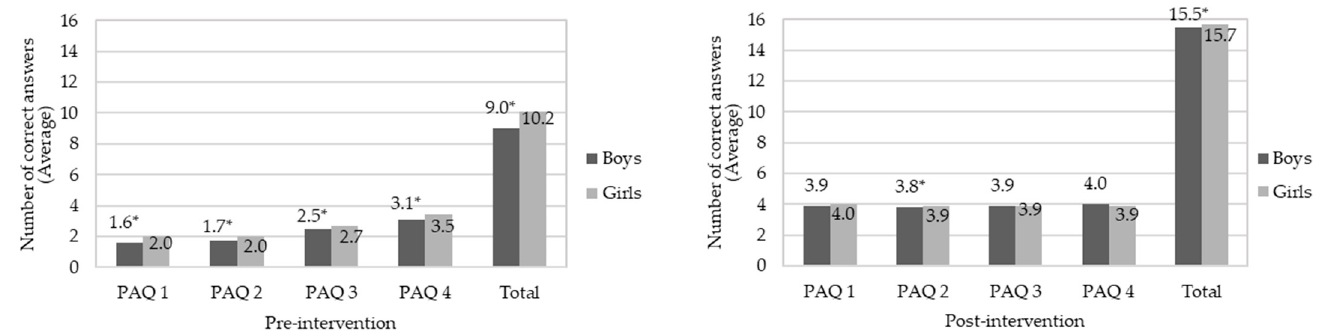
Figure 7. Average of correct answers to questions about knowledge about physical activity in pre- and post-intervention stages, compared between genders. * Means indicate significant difference by Student’s t test ( p -value < 0.05) in the same question. Physical Activity Questions (PAQ): PAQ 1—“Physical activity performed daily prevents which these diseases?”; PAQ 2—“Can exercise lack leads a person to have?”; PAQ 3—“What the practice physical activity improves on a daily basis?”; PAQ 4—“What activities can help you to have good health?”; Each question contained 4 correct answers; for the total there were 16 correct answers.